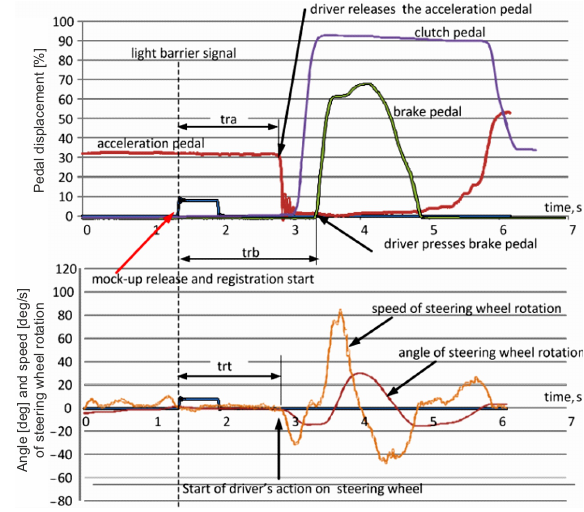
Fig. 11. Example of recorded characteristics of a single